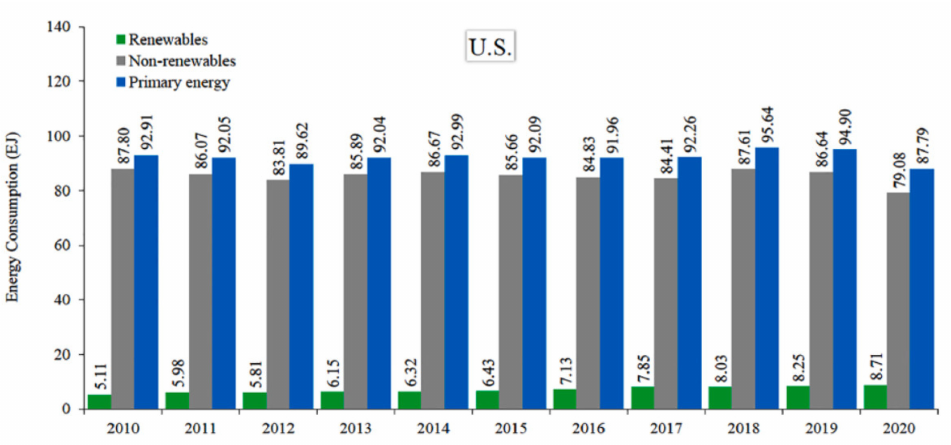
Figure 2. Actual data of energy balances for the U.S. from 2010 to 2020